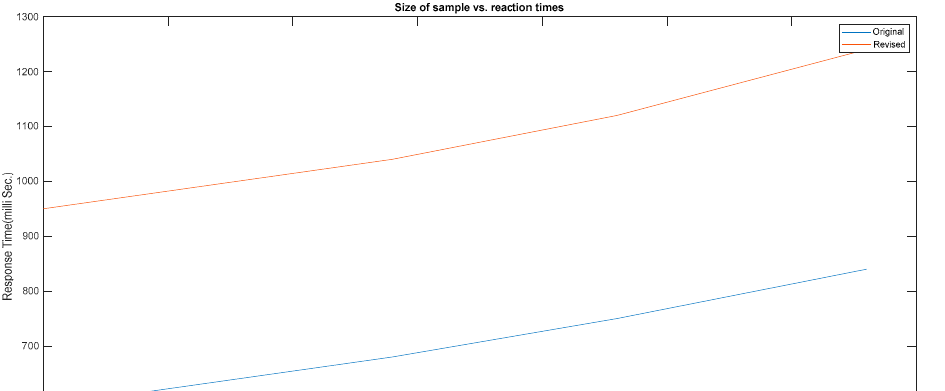
Figure 8. Latencies as a function of data packets sent.